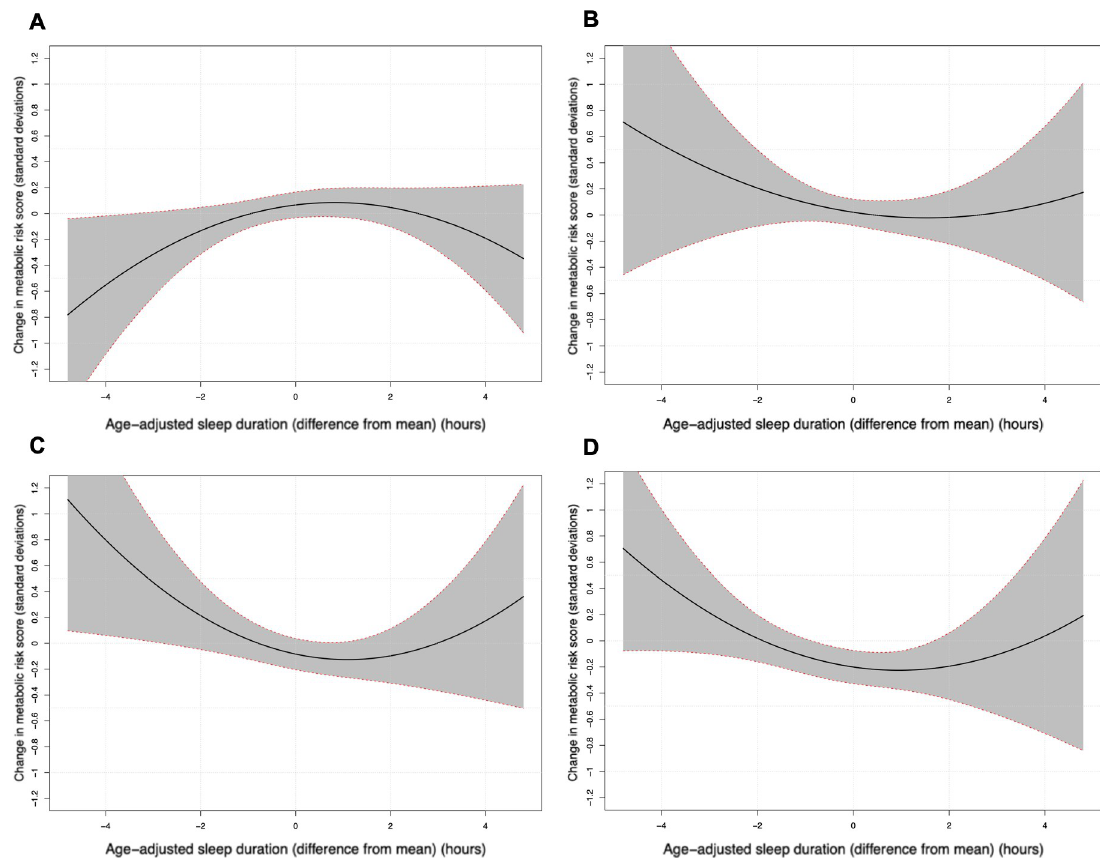
Fig 3. Model predictions of metabolic risk score by age group. Model predictions of metabolic risk score (with 95% confidence intervals) as sleep durations vary above and below the mean, separated by age group (model 3, A: age 11 to 18 years, B: 19 to 35 years, C: 36 to 50 years, D: 51 to 70 years).